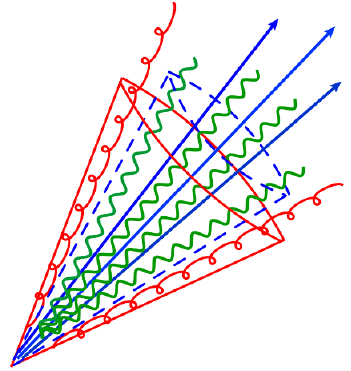
Figure 2 . Schematic illustration of the relevant modes for the refactorized siJMFs when soft drop grooming is included. The green lines represent the soft mode that passes the soft drop criterion. Soft radiation at larger angles that fails the soft drop criterion is illustrated by the red lines. The blue lines represent the more energetic collinear radiation inside the jet which is not a(cid:11)ected by the soft drop grooming algorithm up to power corrections. The dashed blue jet cone represents the groomed jet obtained from the ungroomed jet shown in